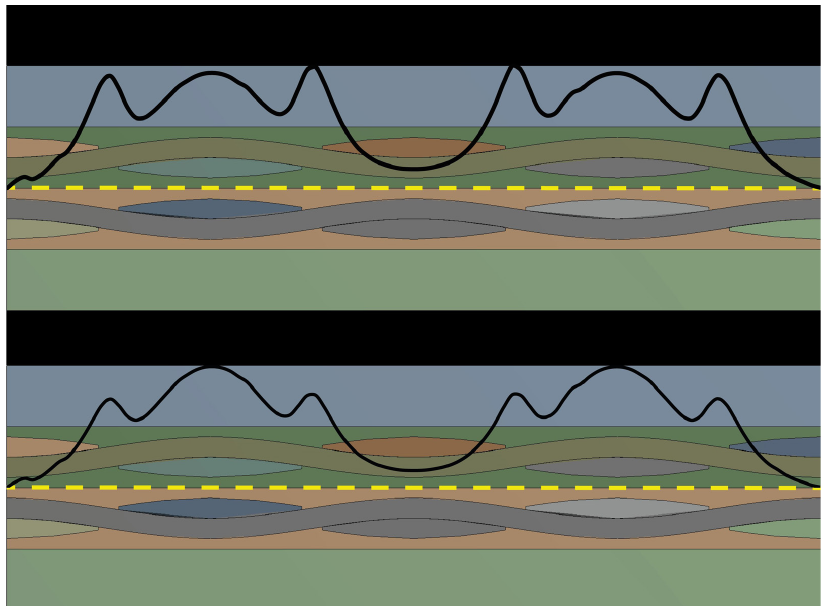
Figure 11. Distribution of the energy release rate on the delamination front prior to the propagation start. A – the UD230 model. B – the UD395 model. The yellow dashed line represents the delamination front.